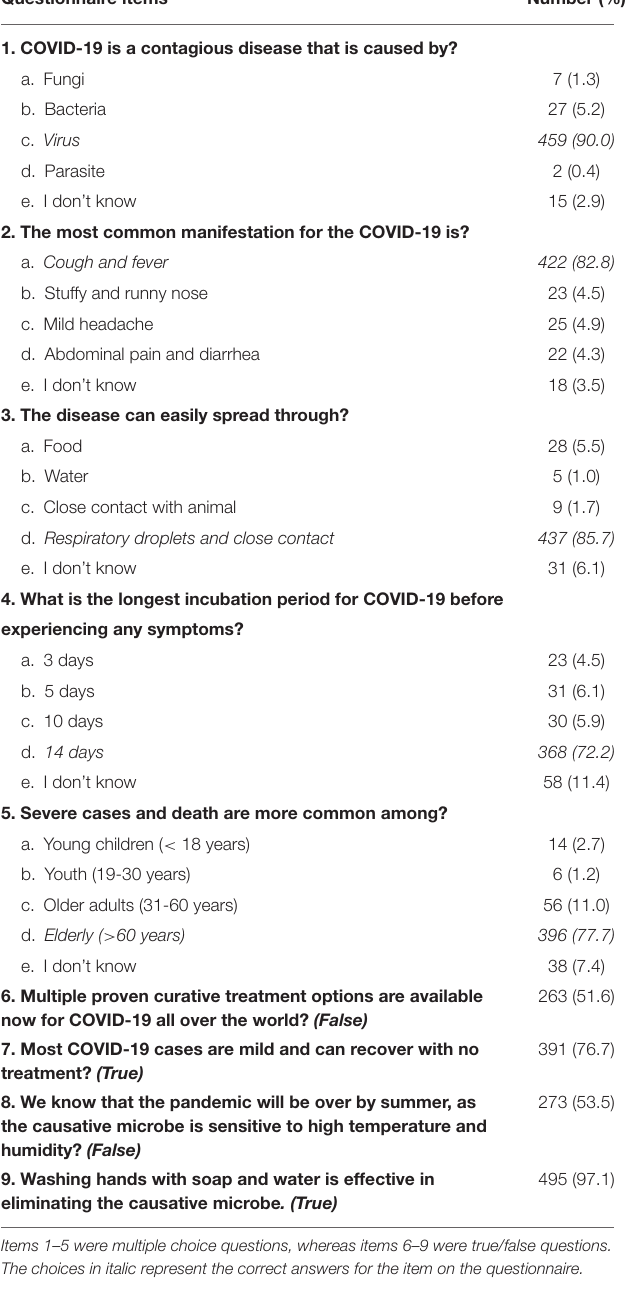
TABLE 3 | Responses of the participants to the knowledge items on the questionnaire. Questionnaire